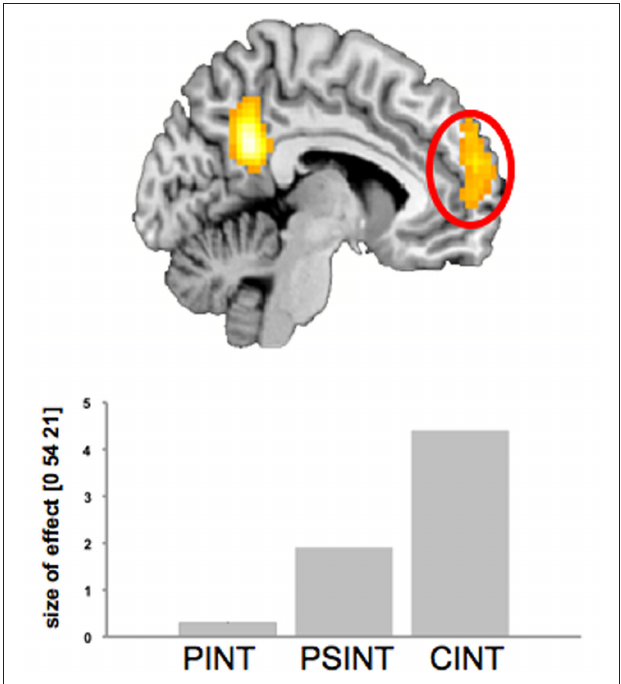
FIguRe 7 | Statistical parametric map (SPM{Z}) of the between-condition effect [CInt > PInt; random effects analysis, ANOVA FDR corrected (0.05)]. The activation profile for the MPFC in all three conditions is shown in the lower part. The bars indicate effect size (mean of parameter estimates from a single-subject analysis) for the respective condition against control condition Ph-C. Bonferroni’s post hoc test was significant for all between-condition comparisons. Ph-C, Physical causality; PInt, Private intention; CInt, Communicative